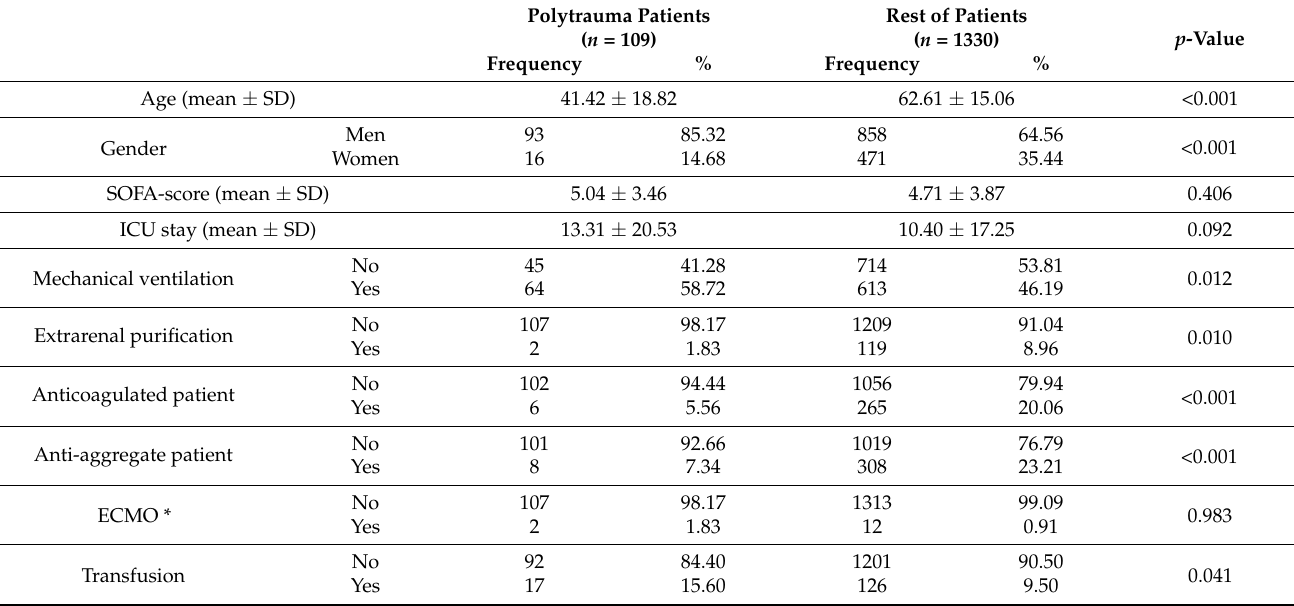
Table 1. Demographic and Clinical Characteristics of the Sample. Polytrauma patients; rest of patients.